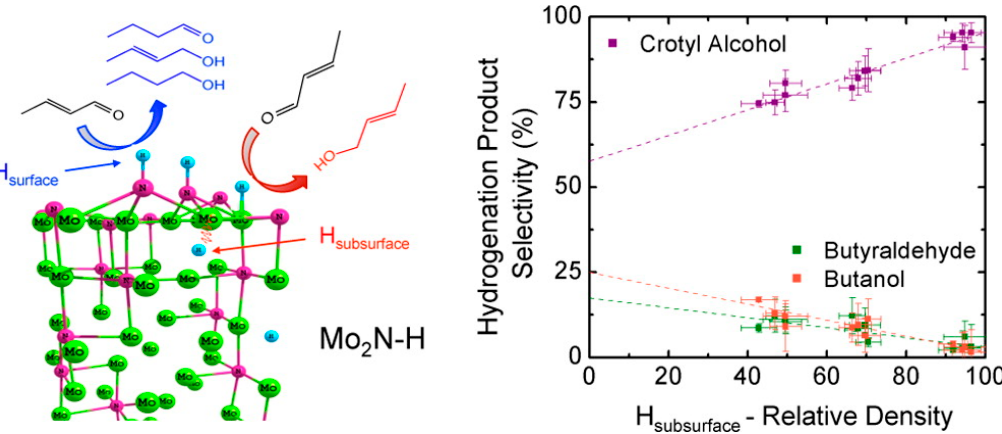
Figure 7. Reproduced from [45], with permission from American Chemical Society, 2016.